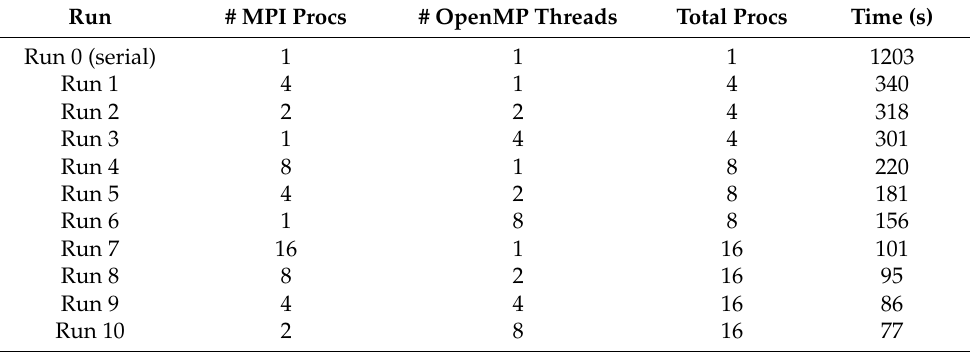
Table 1. Table showing the comparison of the execution times for different MPI/OpenMP combi- nations of processes/threads for N = 10 5 net-points . Except for the case of Run 0, where the code is executed in serial mode, in all other cases, the code is executed on 4, 8 and 16 total processes (we consider here an OpenMP thread as a process) with different combinations of MPI/OpenMP processes/threads in order to see whether the OpenMP parallelization improves the speed-up with respect to the pure MPI case (Runs 1, 4 and 7). Run # MPI Procs # OpenMP Threads Total